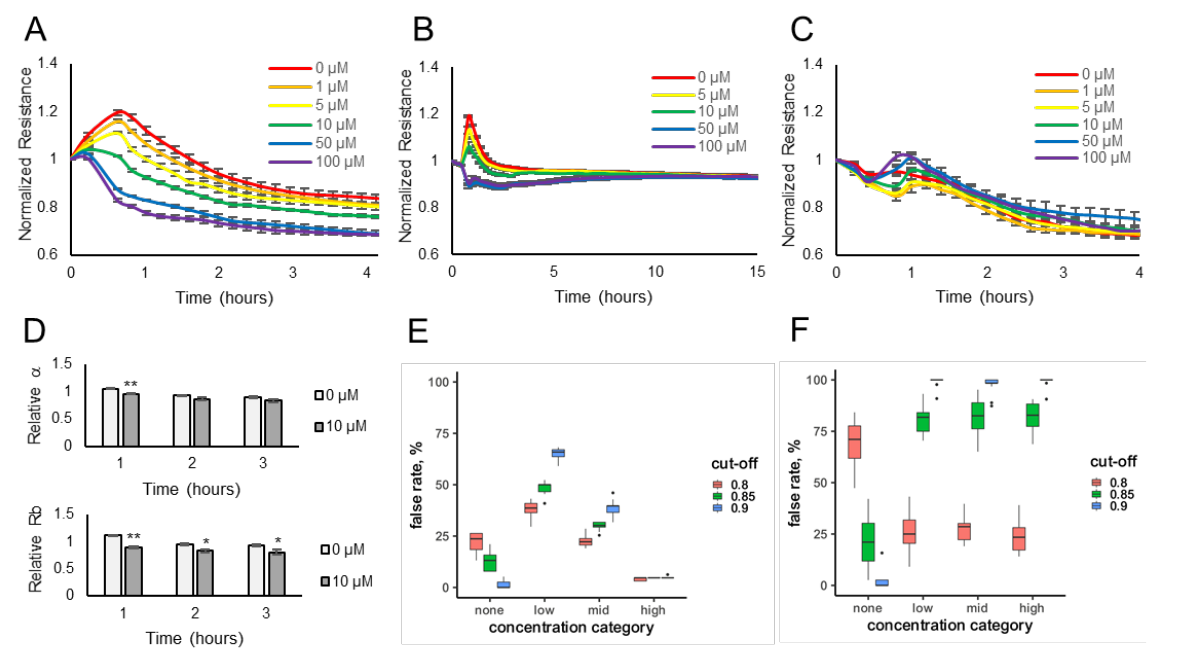
Figure 2. Sandalore exposure causes a transient dose-dependent decrease in cellular resistance. HaCaT monolayers (expressing the OR2AT4 receptor) were exposed to different concentrations of Sandalore (1–100 µ M), and resistance was monitored over a 4 h ( A ) or 15 h ( B ) period. ( C ) HUVEC monolayers (not expressing the OR2AT4 receptor) were exposed to different concentrations of Sandalore (1–100 µ M), and resistance was monitored over a 4 h period. Resistance values (ohms) were normalized to initial readings before odorant addition. Data represented as mean ± SEM of one in- dependent experiment representative of three experimental repeats. ( D ) HaCaT multi-frequency resistance data were modeled to derive the parameters, α (basal adhesion) and R b (paracellular bar- rier), after a 1-, 2-, or 3-h exposure to Sandalore (0 or 10 μ M). Both α and R b values are represented as relative to initial α and R b values before odorant addition. Data shown as mean ± SEM of 3 inde- pendent experiments; ** p < 0.01 and * p < 0.05 as indicated. Statistical model prediction accuracy using the actual resistance data ( E ) or permuted (randomly rearranged) resistance data ( F ). The x- axes represent the Sandalore concentration category: none (0 μ M), low (0.01 to 0.5 μ M), medium (1.0 to 5.0 μ M), and high (greater than 5.0 μ M), and the y-axes show the false rate percentage, re- flecting false positive or negative rates depending on the x-axes categories. Samples in the none category but mis-predicted as containing odorant are false positives. Samples in the low, medium, or high category but that do not contain odorant are the false negative rate, also plotted on the y- axes.